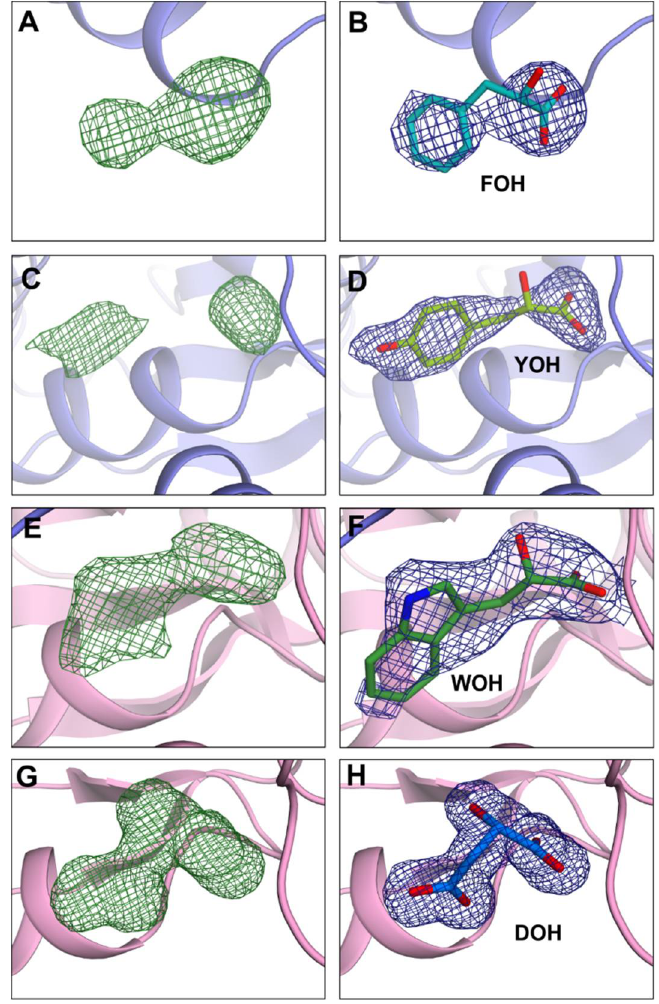
Figure 5. Unit cells. The electron density maps for ligands in Psy ArAT complexes. ( A , C , E , G ) The electron density omit map Fo-Fc , indicating the presence of FOH, YOH, WOH and DOH, respectively. ( B , D , F , H ) The electron density map 2Fo - Fc displayed on FOH, YOH, WOH and DOH, respectively. The electron density maps Fo-Fc (green) were contoured at 3.0 σ , and 2Fo-Fc were displayed in blue at 1.0 σ.